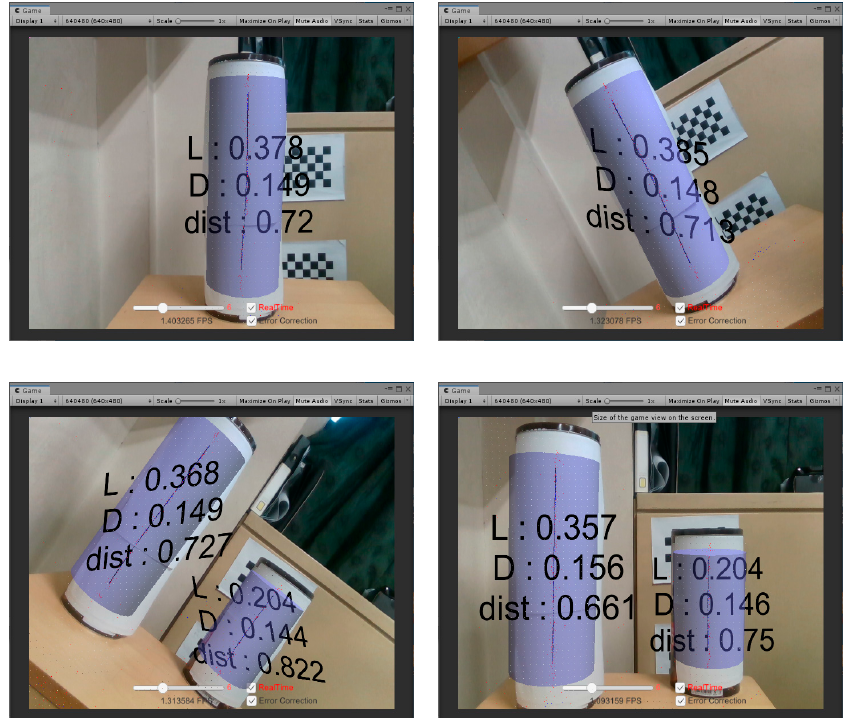
Figure 20. Time of flight sensor real-time matching results for six cores and six frames. FOV = 41.5°; 𝛜 = 50 error correction mode (m).